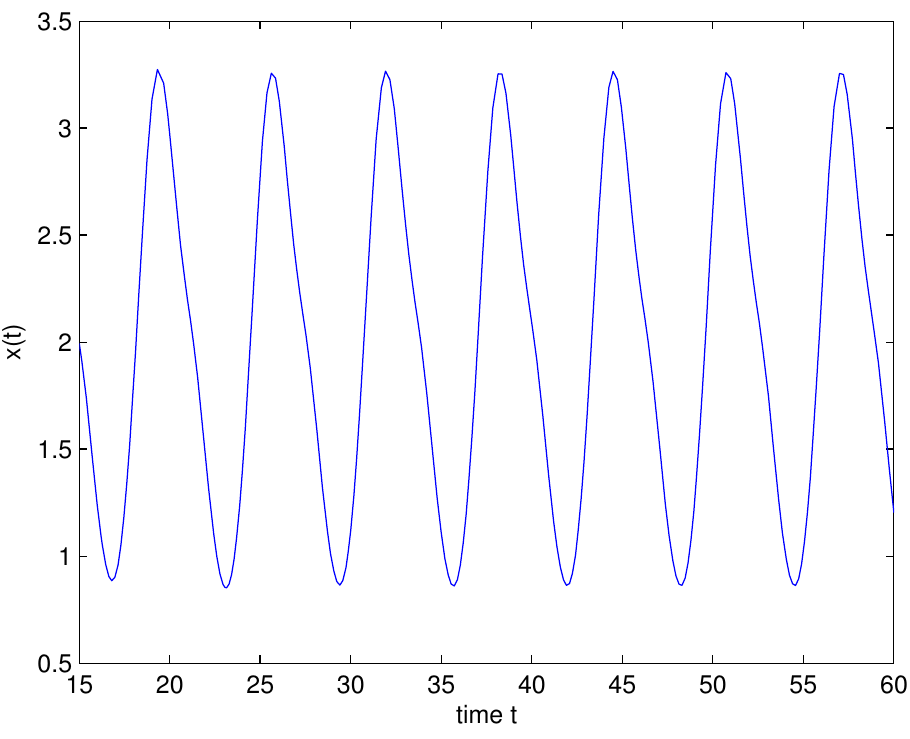
Figure 1. Positive periodic solution x ( t ) to Equation